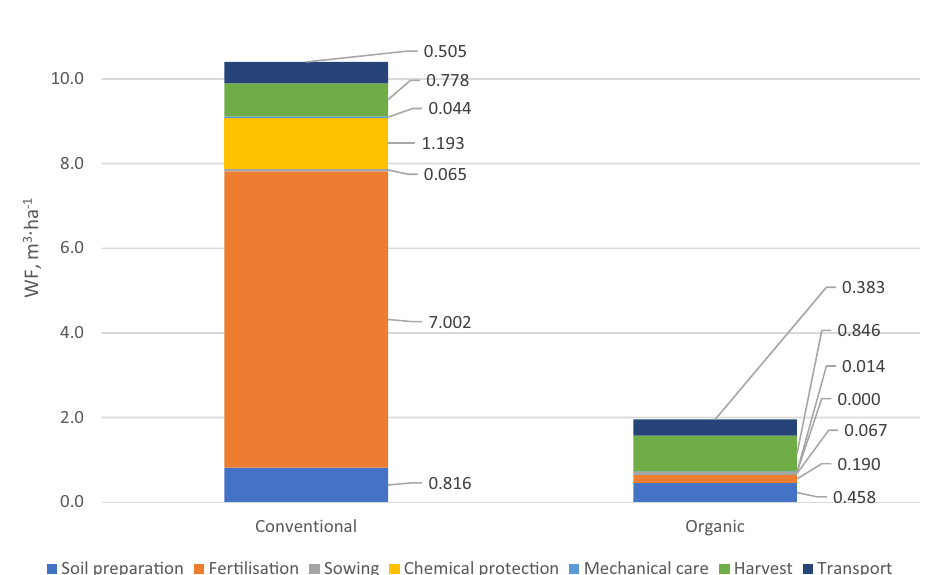
Figure 2. Water footprint in conventional and organic carrot production (m 3 ha −1 ).